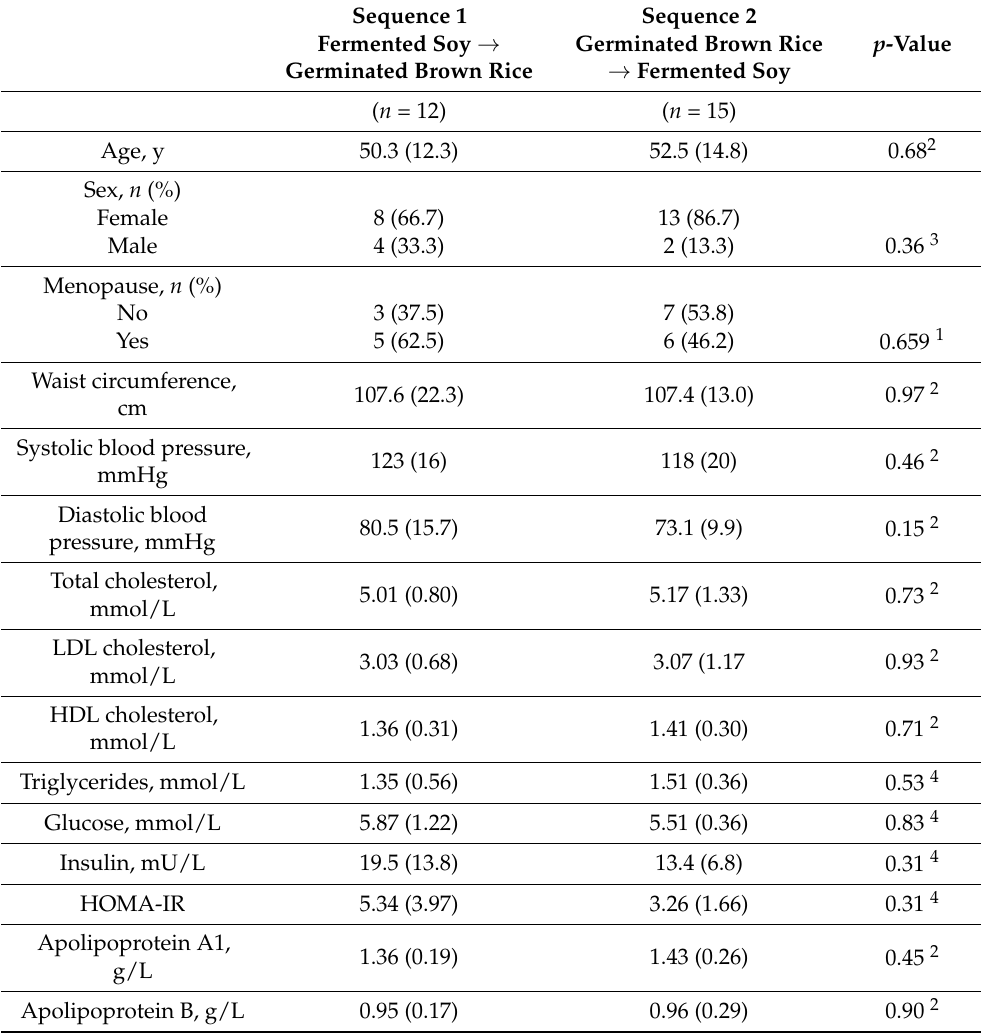
Table 2. Participant characteristics at baseline for the 27 adults with at least 2 risk factors for CVD in the evaluable sample according to randomized group assignment 1